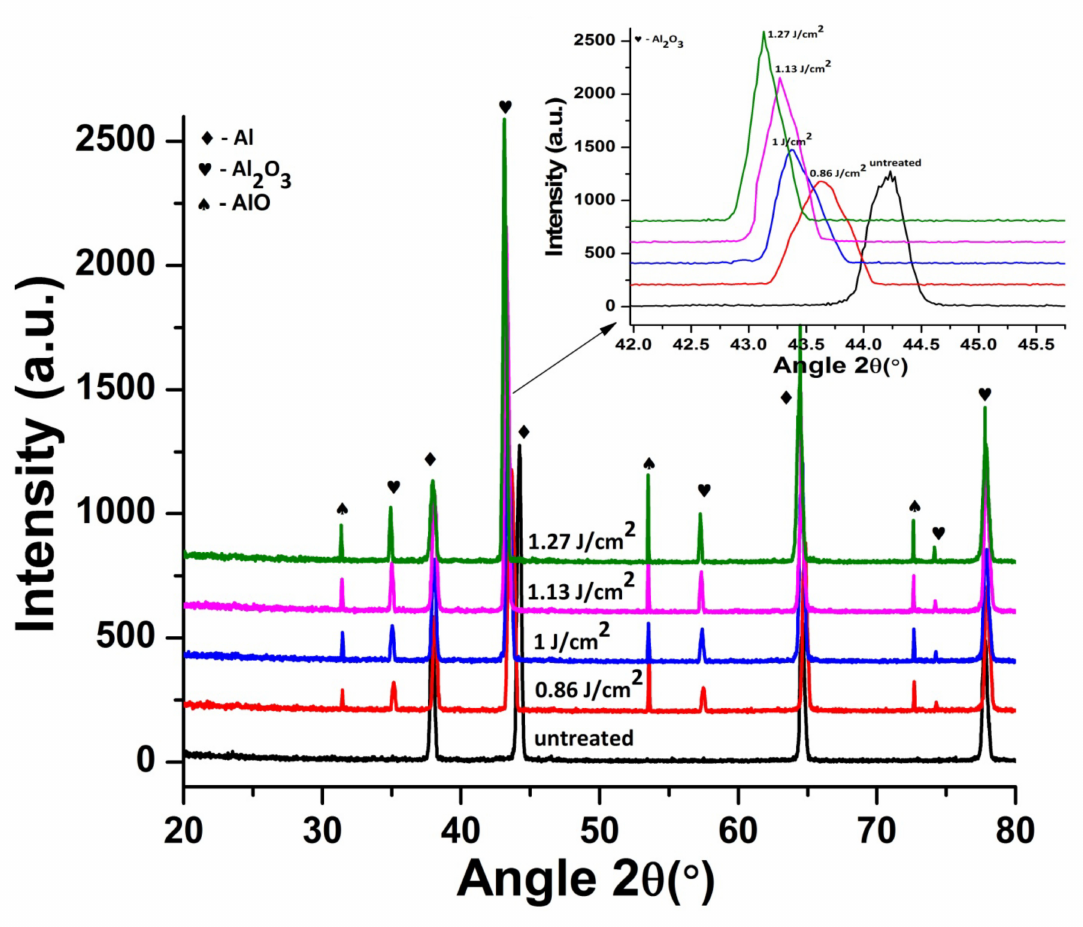
Figure 9. XRD data of un-irradiated and irradiated Al exposed to 100 pulses of ns laser under O 2 environment at pressure of 100 torr, at various fluences of 0.86, 1, 1.13 and 1.27 J · cm − 2 . Inset of Figure 9 shows the enlarged view of Al (200) peak showing variation in peak position and peak